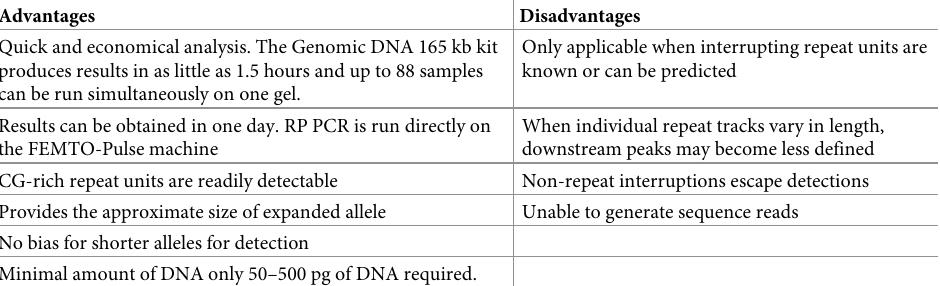
Only applicable when interrupting repeat units are known or can be predicted When individual repeat tracks vary in length, downstream peaks may become less defined